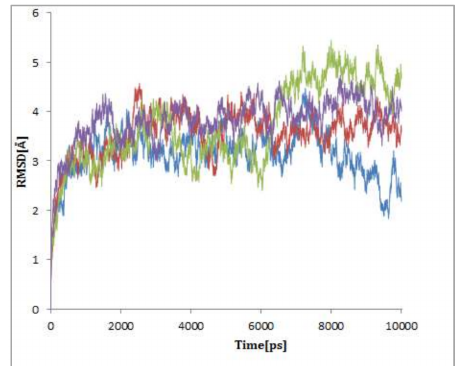
Figure 4. Root mean square deviations (RMSDs) of different complexes during 10 ns of molecular dynamics simulations; RMSDs of boldine (in blue and red) and BSB (green and purple) as ligands in complex with TERT after blind and focused docking screens,